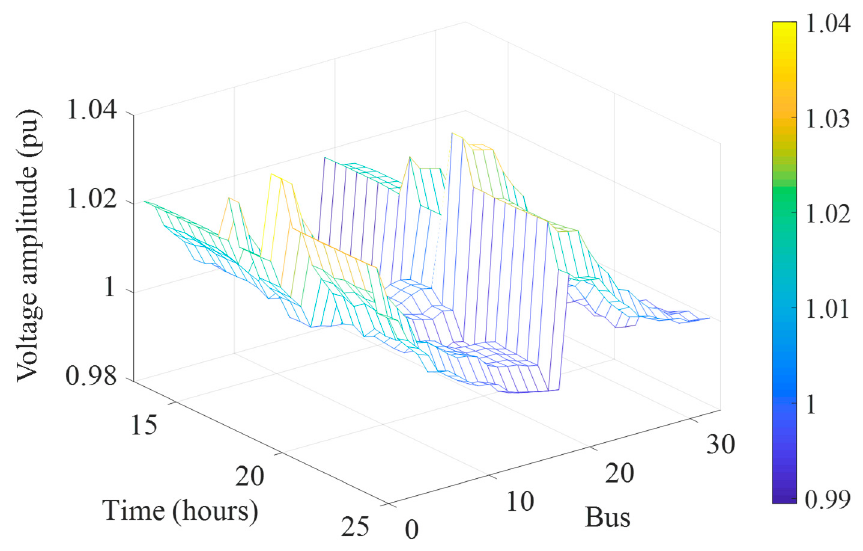
Figure 9. The optimization results of different reactive power-regulating devices.